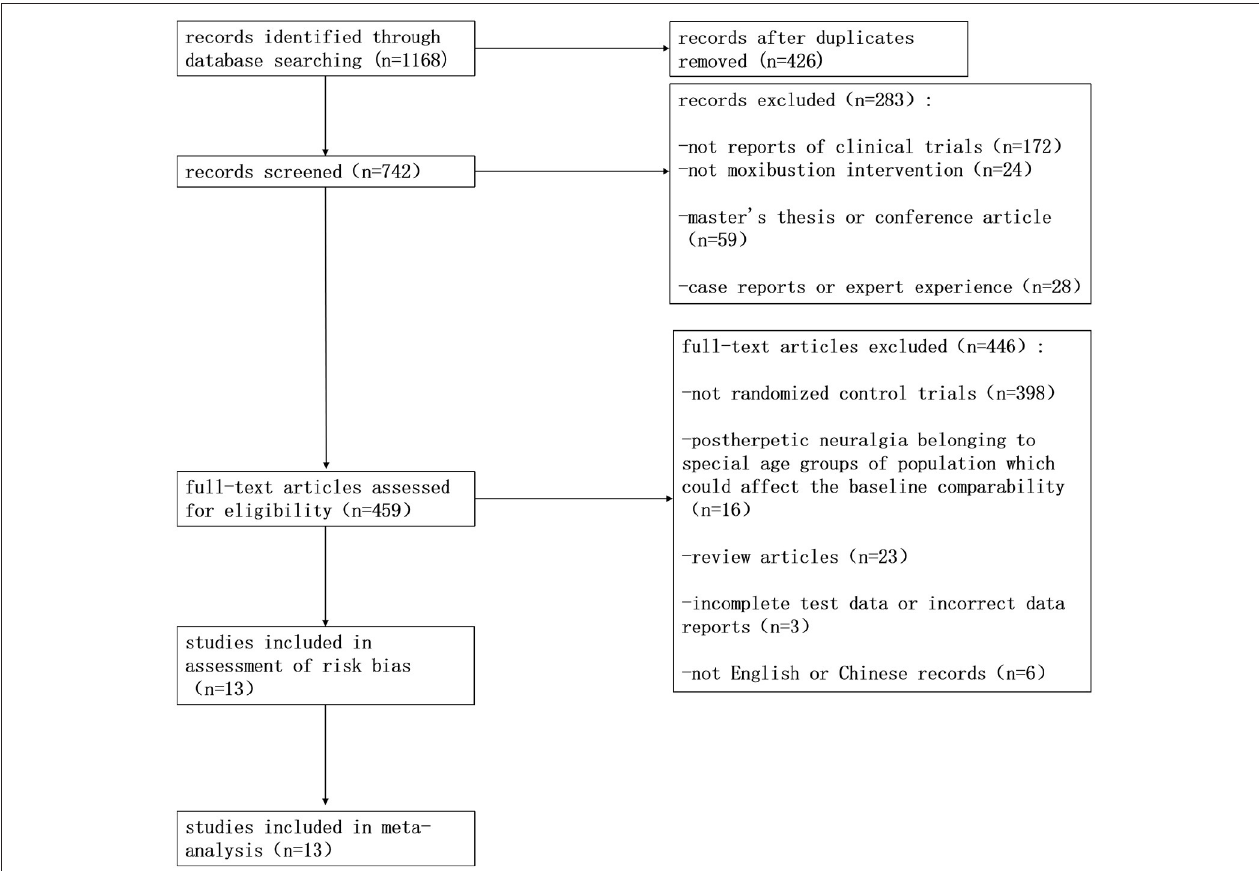
FIGURE 1 | Flowchart of the process used to retrieve relevant articles from the literature.